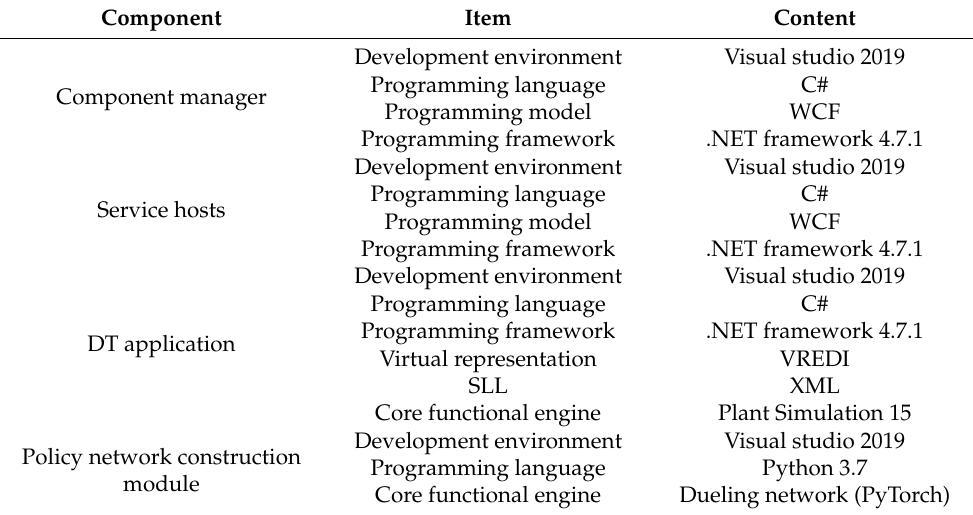
Table 2. Implementation information for industrial case